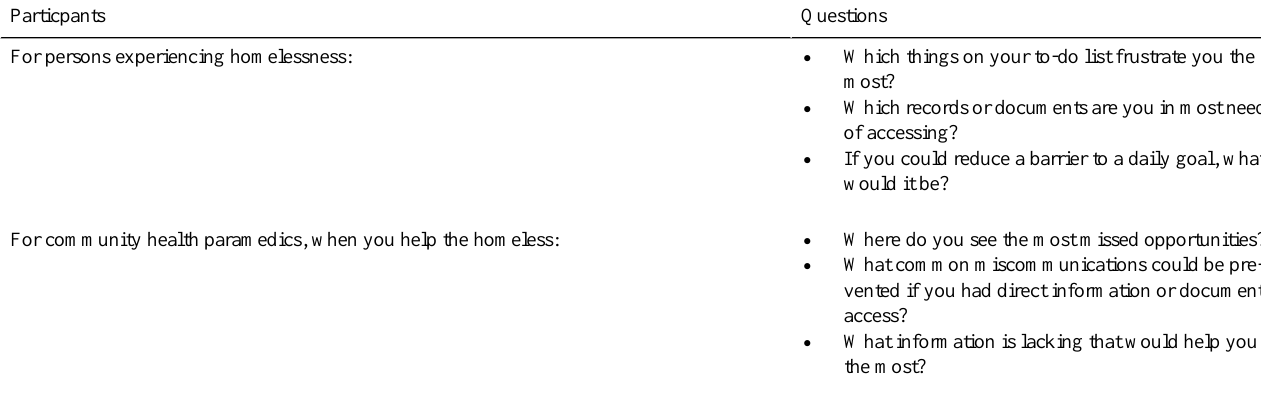
Table 2. Research